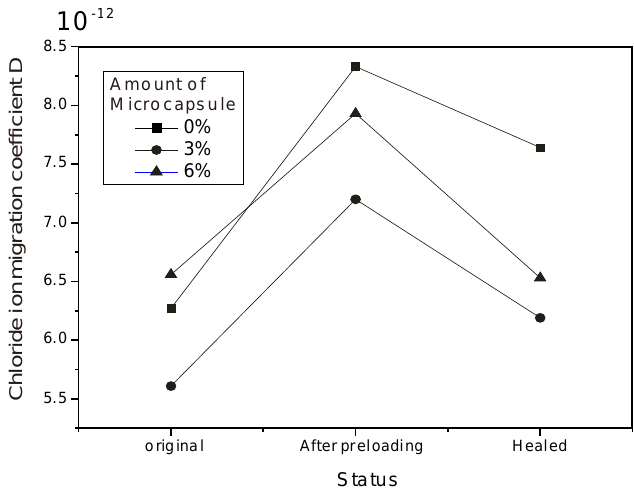
Figure 11. Variation of chloride ion migration